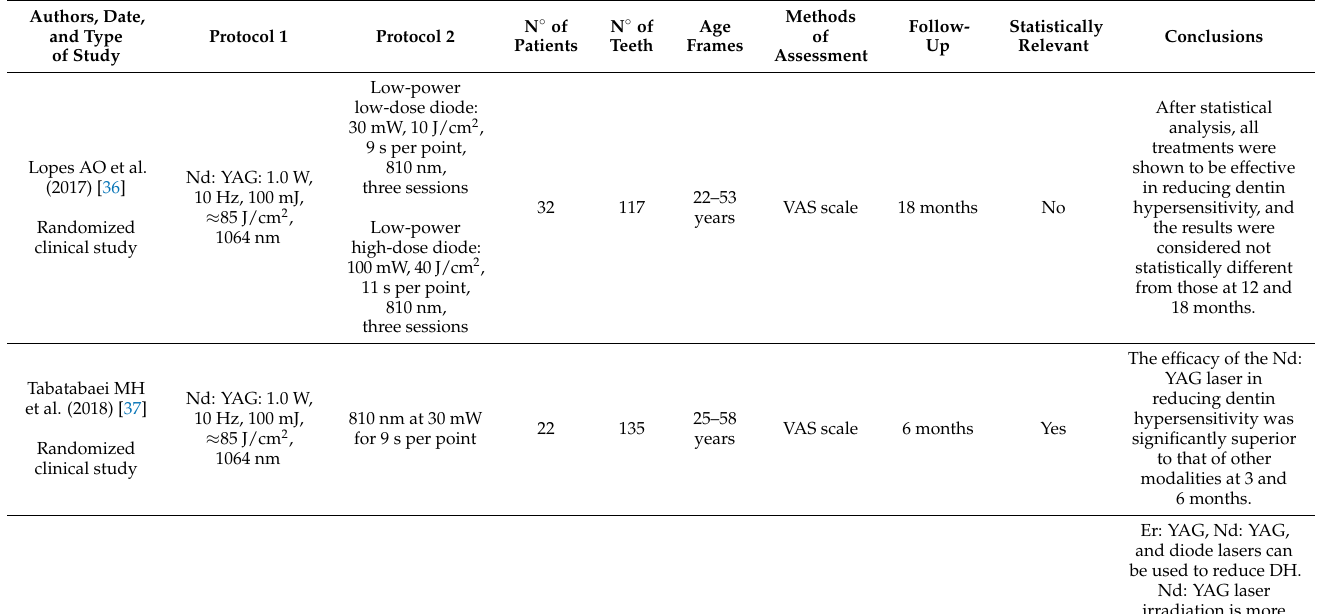
Table 4. Characteristics of studies comparing Nd: YAG laser treatment and low-power diode laser